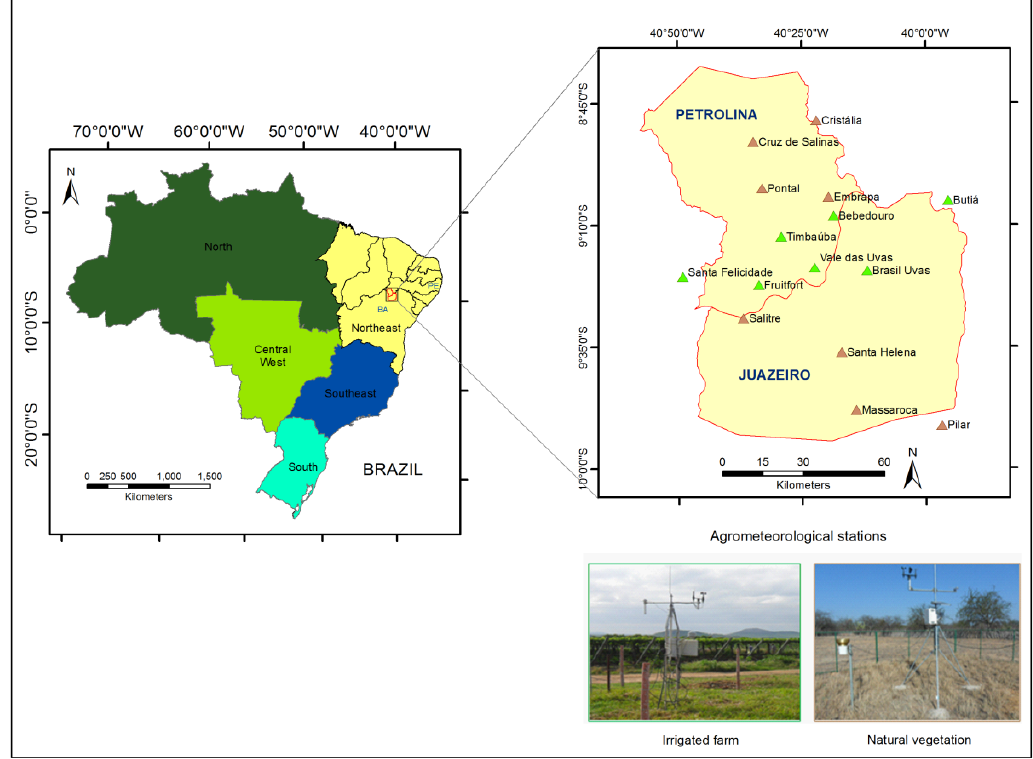
Figure 1. Petrolina and Juazeiro municipalities, respectively in Pernambuco (PE) and Bahia (BA) states, in the Brazilian Northeast, together with the agro-meteorological stations used for the interpolation processes. The stations represented by green triangle are inside irrigated farms while those with brown triangle are in natural